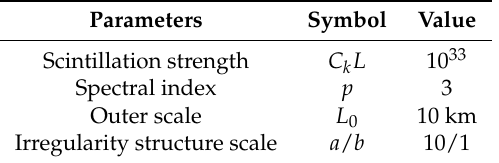
Figure 5. TFTPCF with different L 0 . ( a ) TFTPCF versus frequency separation. ( b ) TFTPCF versus spatial separation. Table 1. The default value of ionospheric irregularity